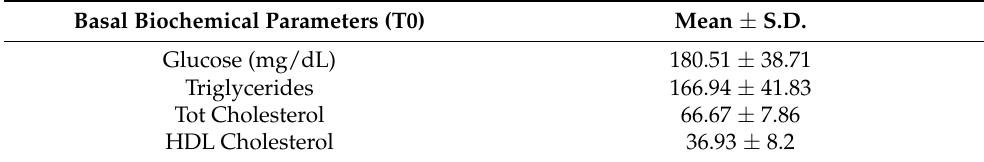
Table 2. Basal metabolic parameters in plasma samples at T0.